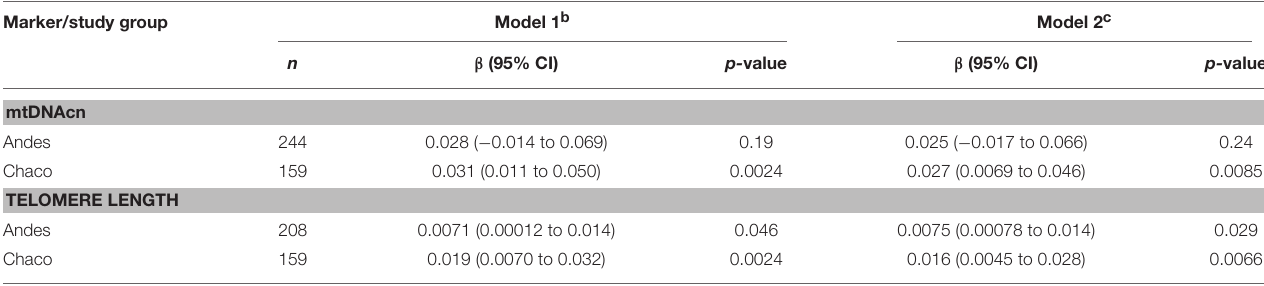
TABLE 2 | Associations of U-As a with log2-mtDNAcn and telomere length in peripheral blood. Marker/study